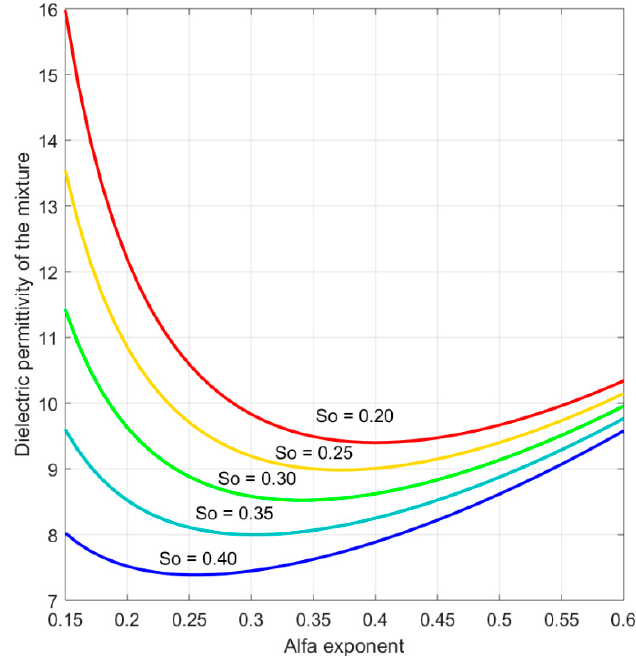
Figure 11. Effect of α -exponent of the CRIM formula on relative dielectric permittivity at different diesel oil contents (S o ), considering a relative water content of 0.4.